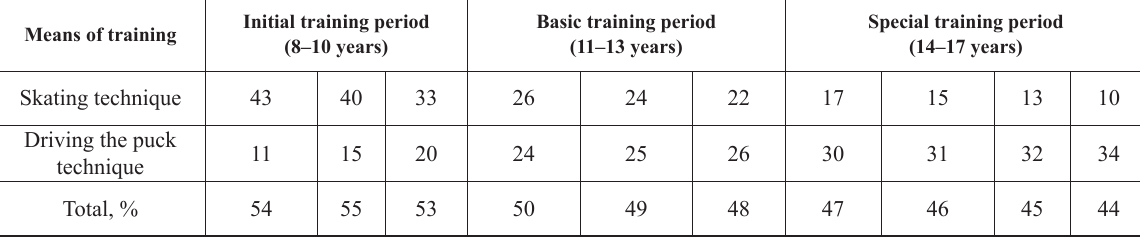
Table 4. Time ratio (%) for skating technique and driving the puck technique at various periods of training Means of training